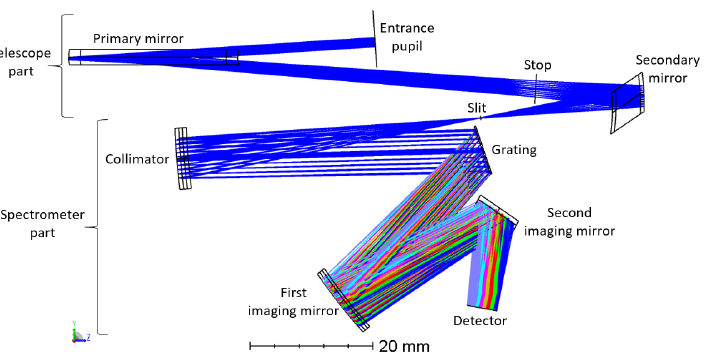
Figure 9. Overall optical design of the fully reflective instrument, featuring a freeform telescope with a field of view of 120° and a freeform spectrometer. The design is compact and fits within 1